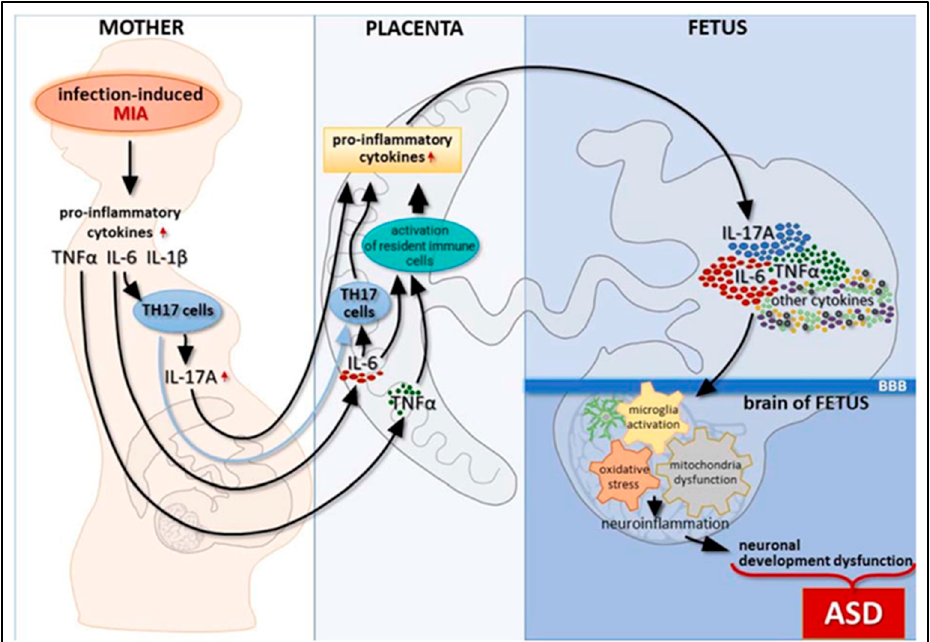
Figure 4. The relation between inflammatory pathways and immunoinflammatory link of ASD during pregnancy. Adapted from Zawadzka, A.; Cie ś lik, M.; Adamczyk, A. The Role of Maternal Immune Activation in the Pathogenesis of Autism: A Review of the Evidence, Proposed Mechanisms and Implications for Treatment. Int. J. Mol. Sci. 2021 , 22 , 11516 [38].